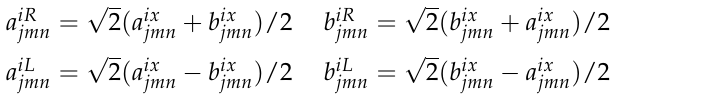
Figure 2. Illustration of the electric components of arbitrarily polarized HOBB. ( a – d ) x-polarized; ( e – h ) y-polarized; ( i – l ) RCP mode; ( m – p ) LCP mode. 3. Multi-Scattering Theory Taking into account the eigen-mode in chiral media made up of two parts: the RCP wave with 0 0 1 ( ) c c k με μεω κ= + and LCP wave with 0 0 2 ( ) c c k με μεω κ= − ; where c ε , c μ , and κ represent the permittivity, permeability, and chirality parameter of